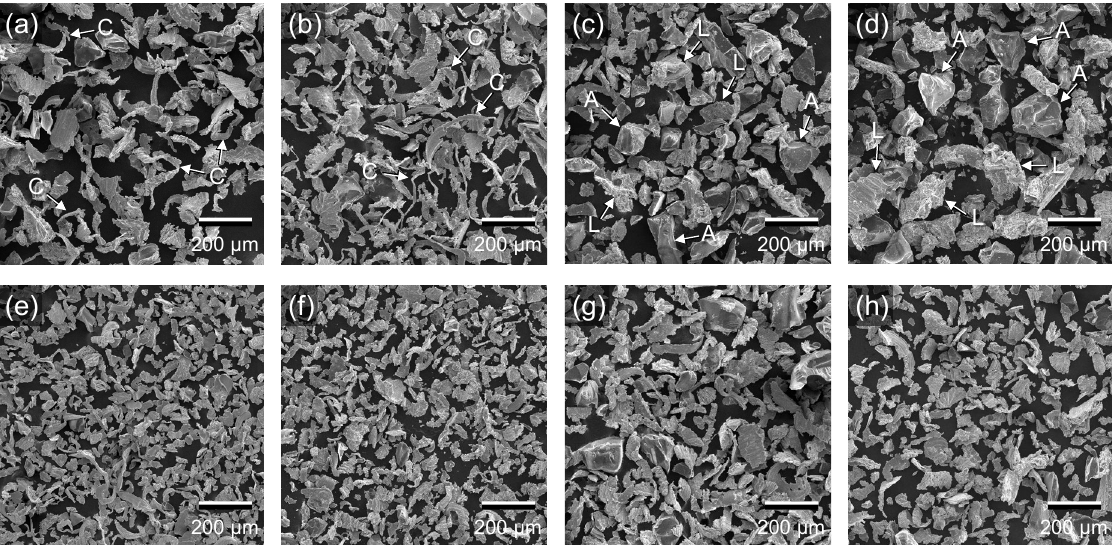
Figure 5. Metal chips resulting from grinding: ( a ) Ti; ( b ) 6Nb4Cu; ( c ) 18Nb2Cu; ( d ) 24Nb1Cu at 750 m/min; ( e ) Ti; ( f ) 6Nb4Cu; ( g ) 18Nb2Cu; ( h ) 24Nb1Cu at 1500 m/min. Arrows and alphabet indicate C: curly chips, L: lumpy (not curly) chips, A: abrasive grains.